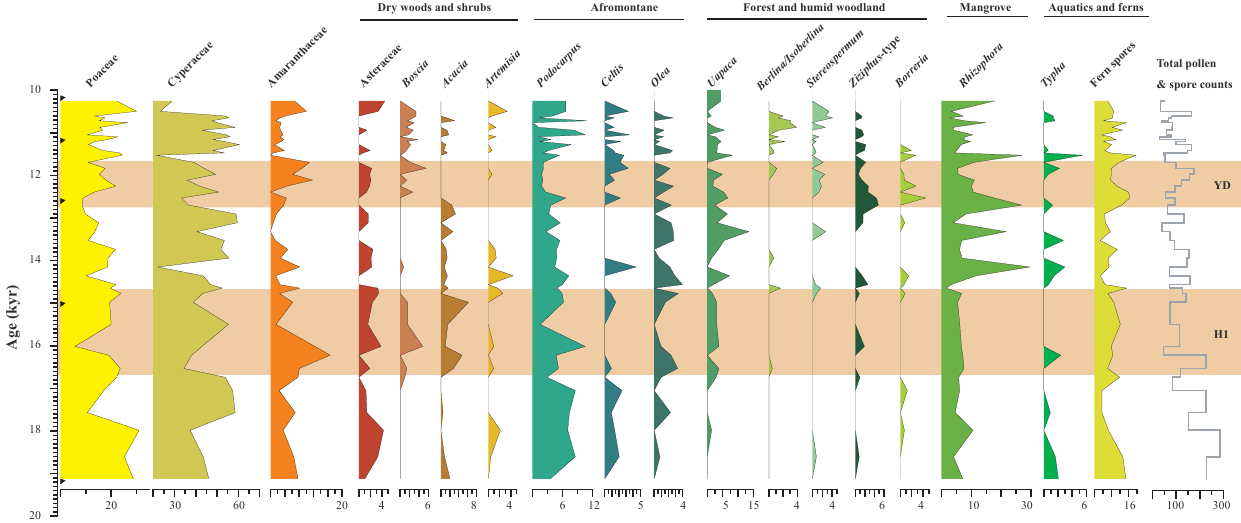
Figure 5. Palynological data from marine sediment core GeoB12624-1 showing relative abundances (%) of selected pollen taxa, percentages of fern spores and the total pollen and spores counts. Note scale changes on x axes. Shading indicates time intervals of Heinrich event 1 (H1) and the Younger Dryas (YD). Triangles indicate age control